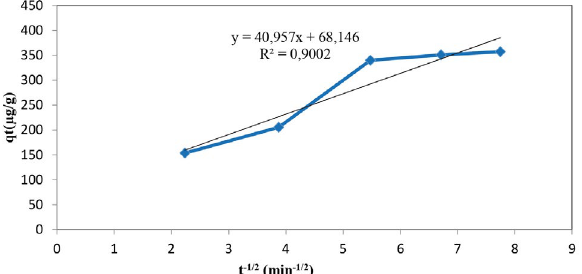
Figure 9. Morris-Weber kinetic model for Cr(VI) sorption onto isatin based Amberlite XAD-2